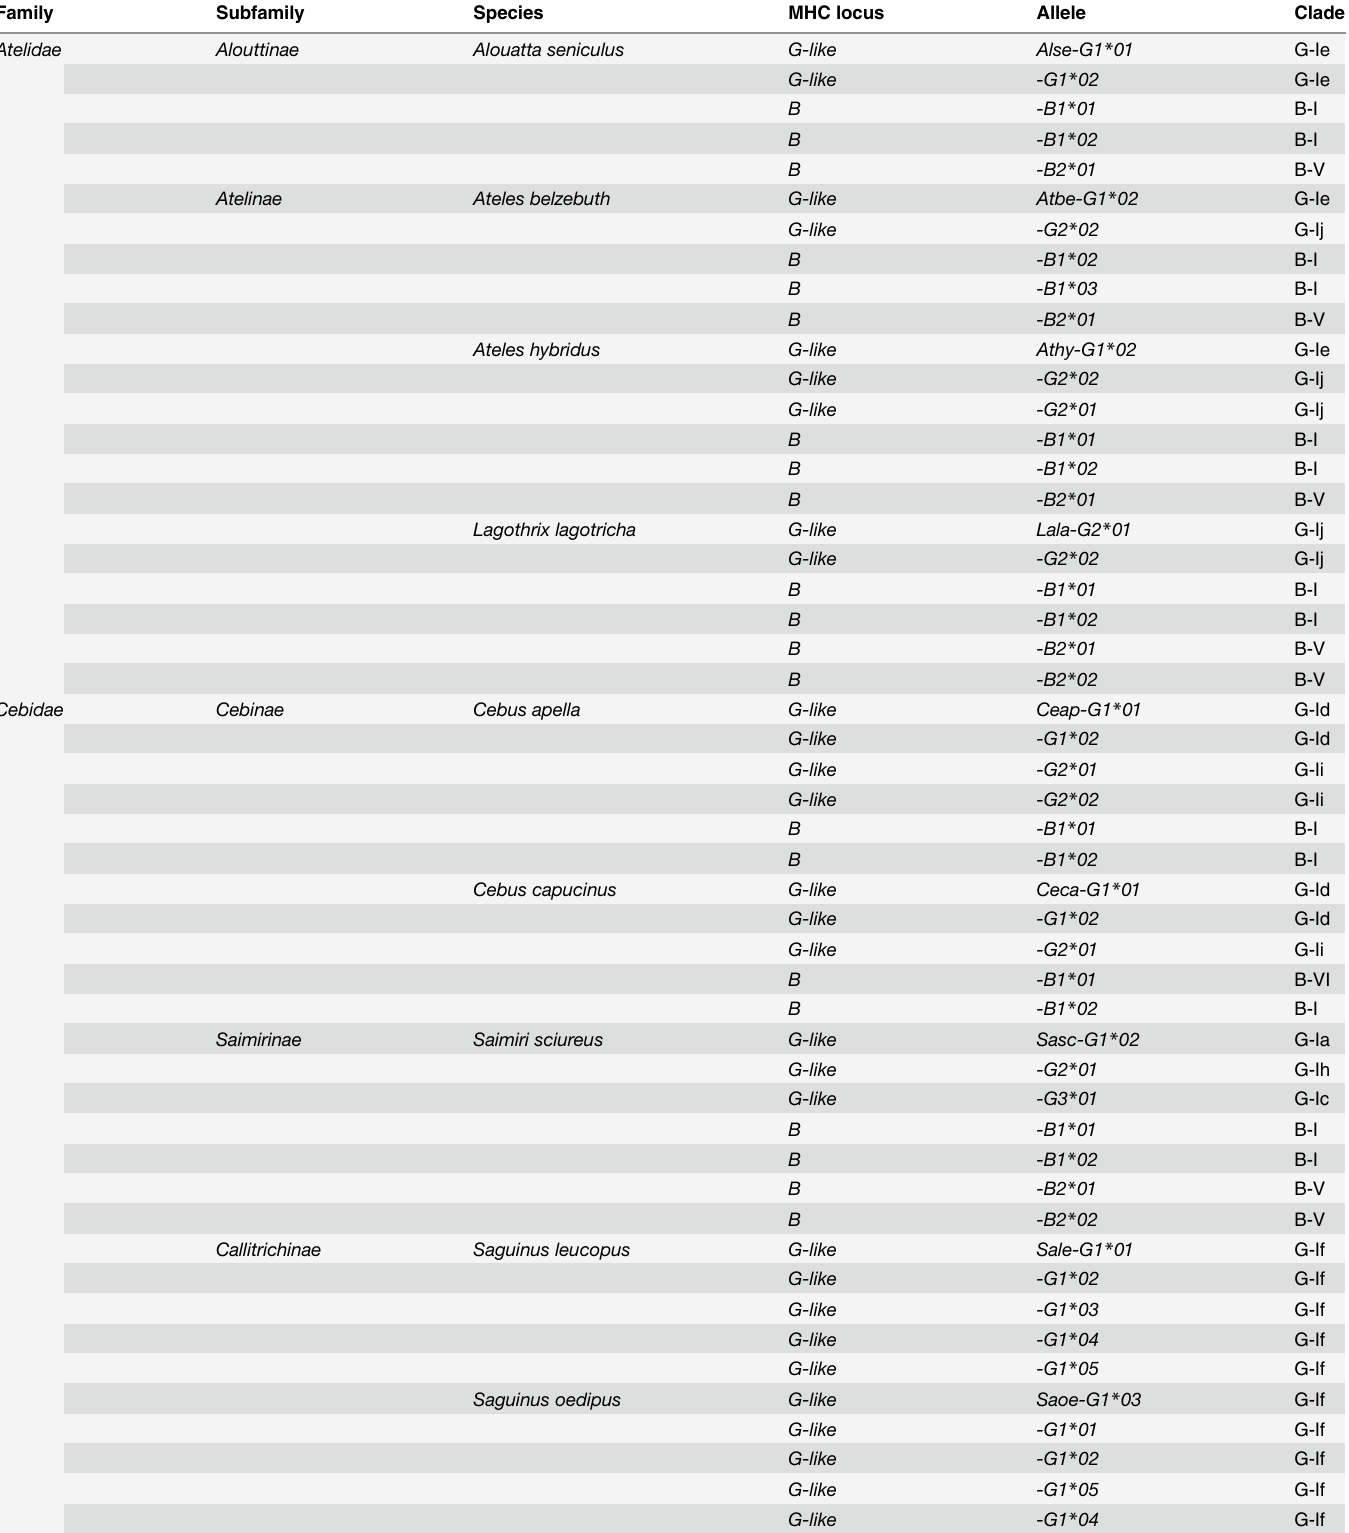
Table 1. MHC-G-like and – B cDNAs identified in representative species of the Platyrrhini families Atelidae and Cebidae .